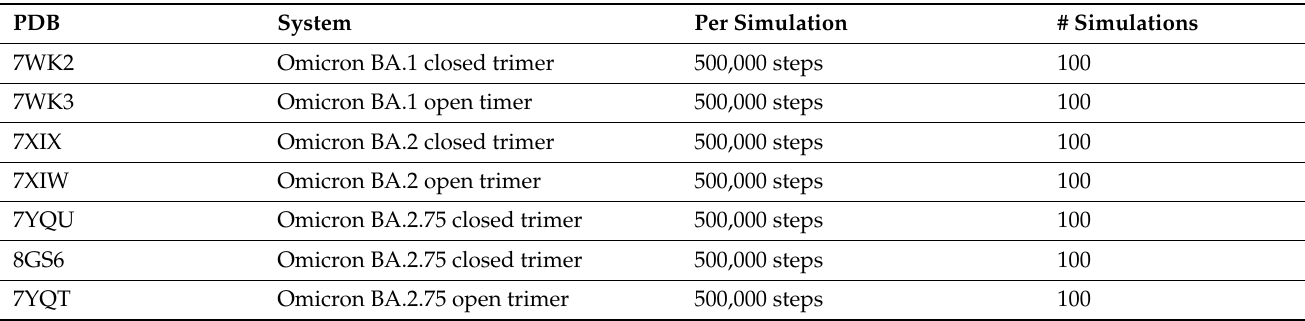
Table 3. Structures of the S Omicron trimers examined in this